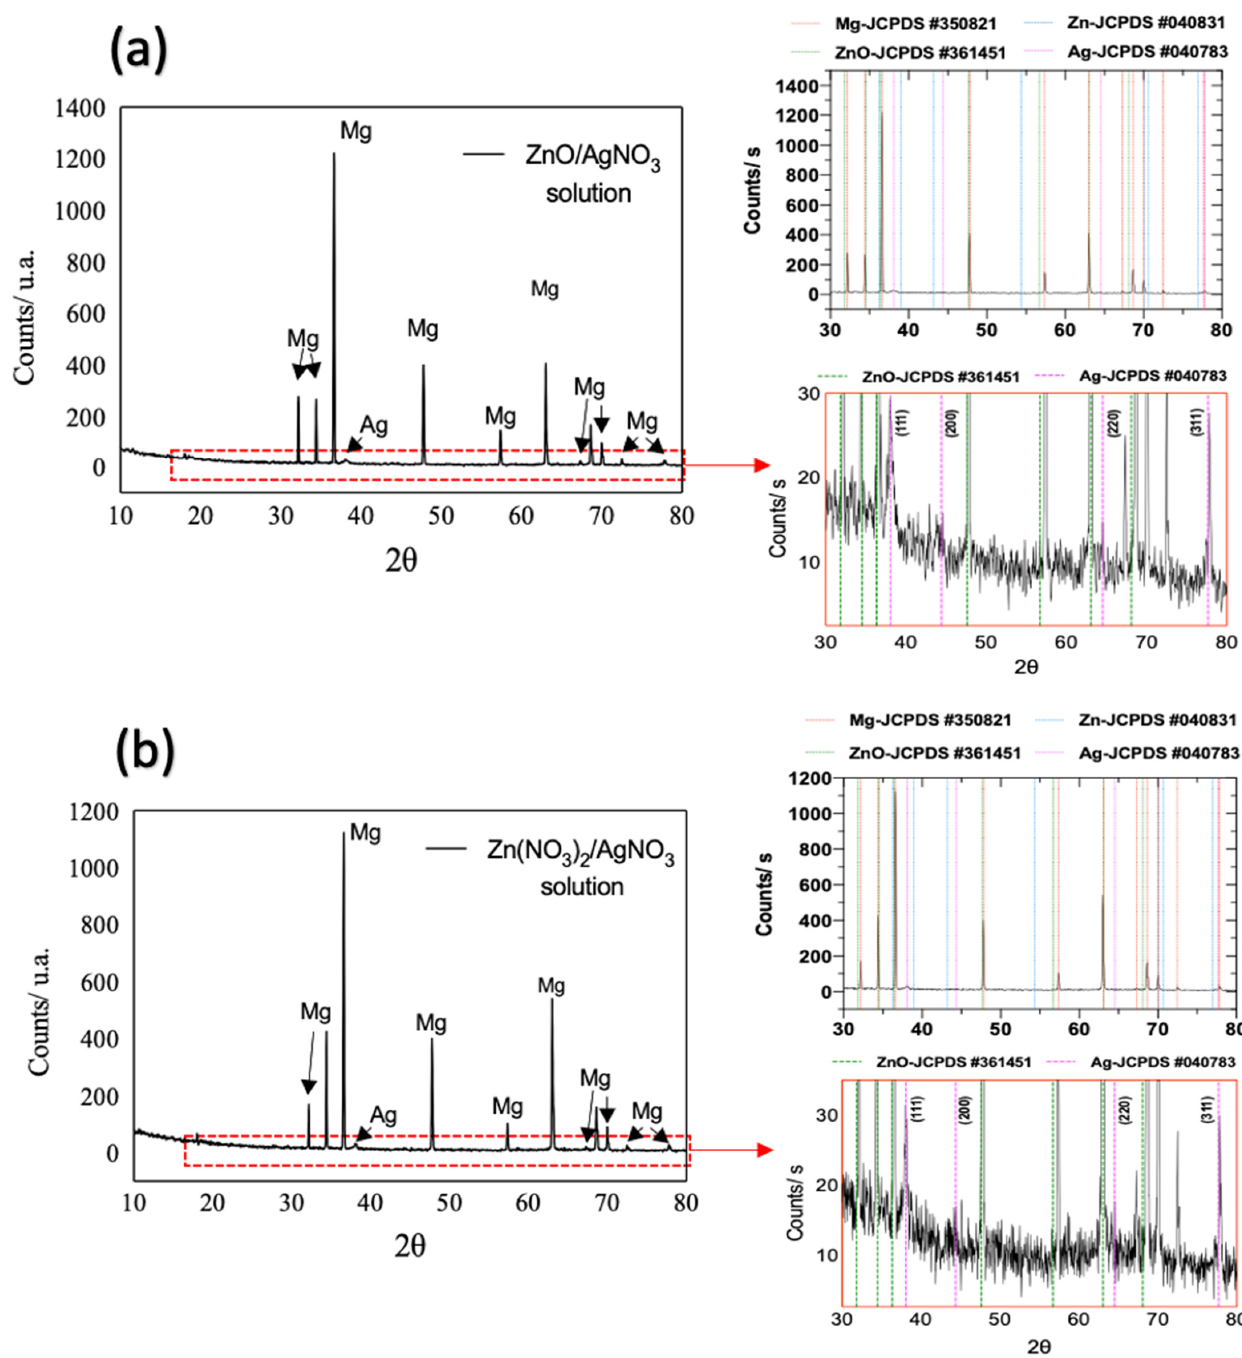
Figure A2. XRD spectra of Hybrid ZnO/Ag electroless deposits on Mg–Ca0.3 surface achieved from 10 − 3 M solutions of ZnO/AgNO 3 ( a ) and Zn(NO 3 ) 2 /AgNO 3 ( b ).